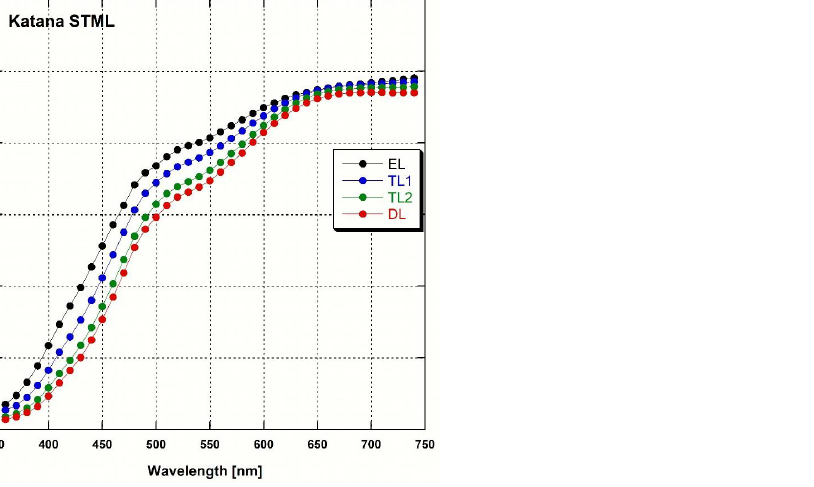
Figure 3. Spectral transmittance curves for each layer of the 5Y-zirconia (Katana STML). Table 3. Optical properties of each group of zirconia specimens (mean ± SD).